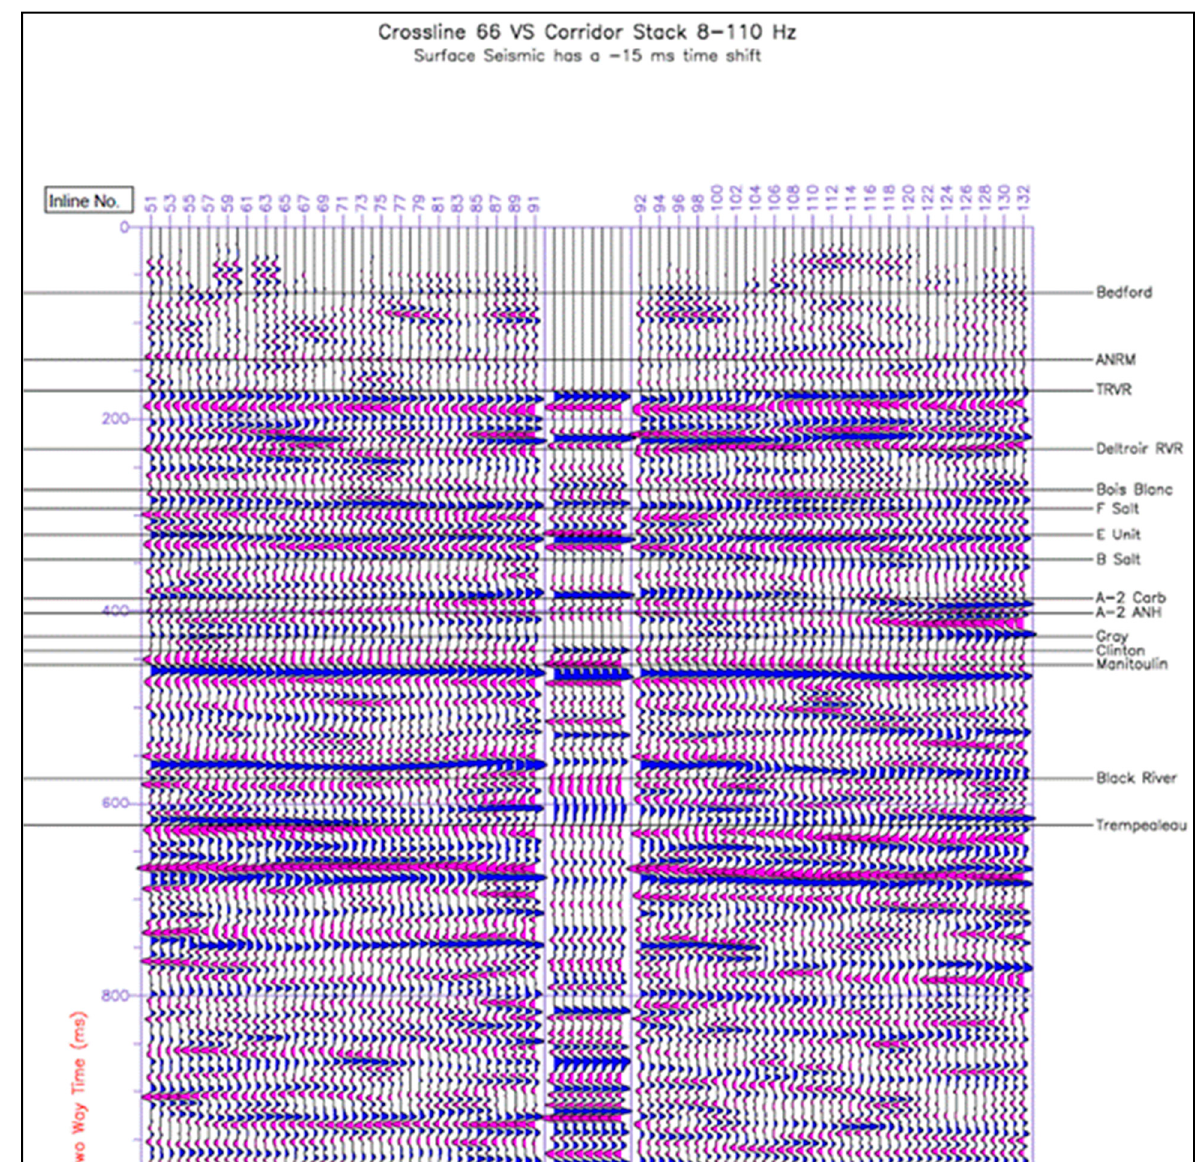
Figure 2. Correlation plot created from the vertical seismic profile (VSP) at well P-201 (see Figure 1C for location) through crossline 66 (north-south direction).